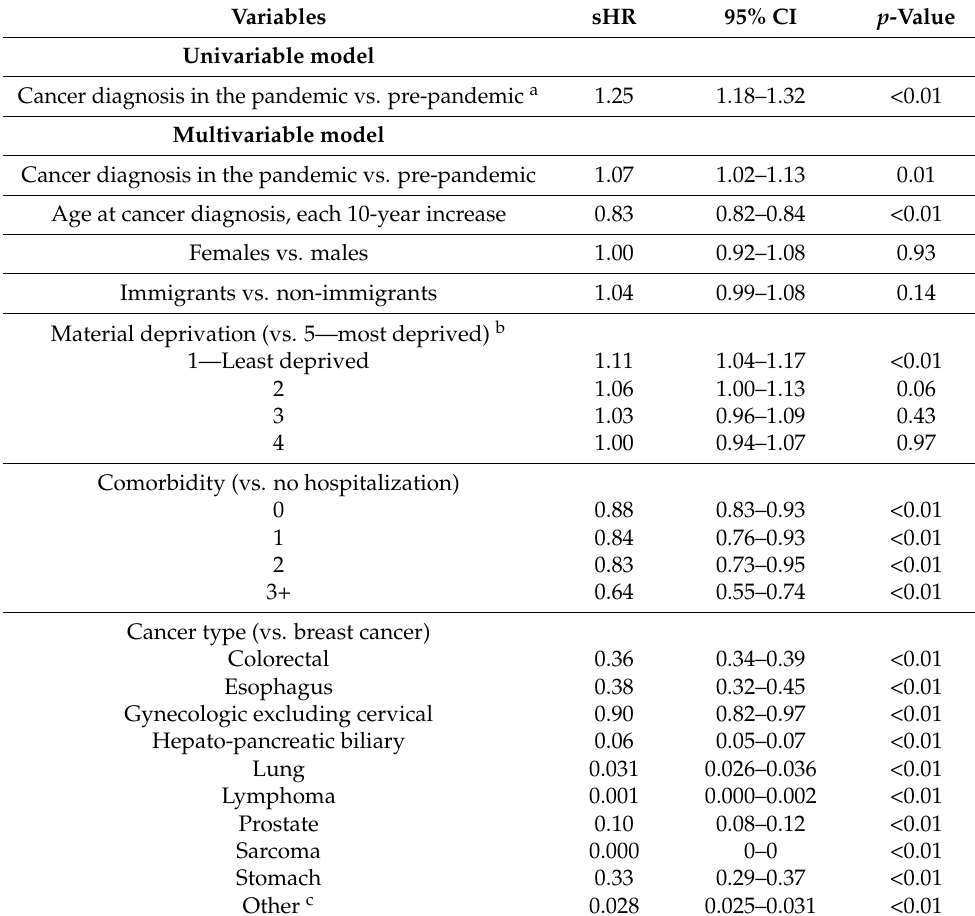
Table 2. Competing risks regression results showing the COVID-19 impact on receipt of surgery in 9 months after first chemotherapy for patients first treated with